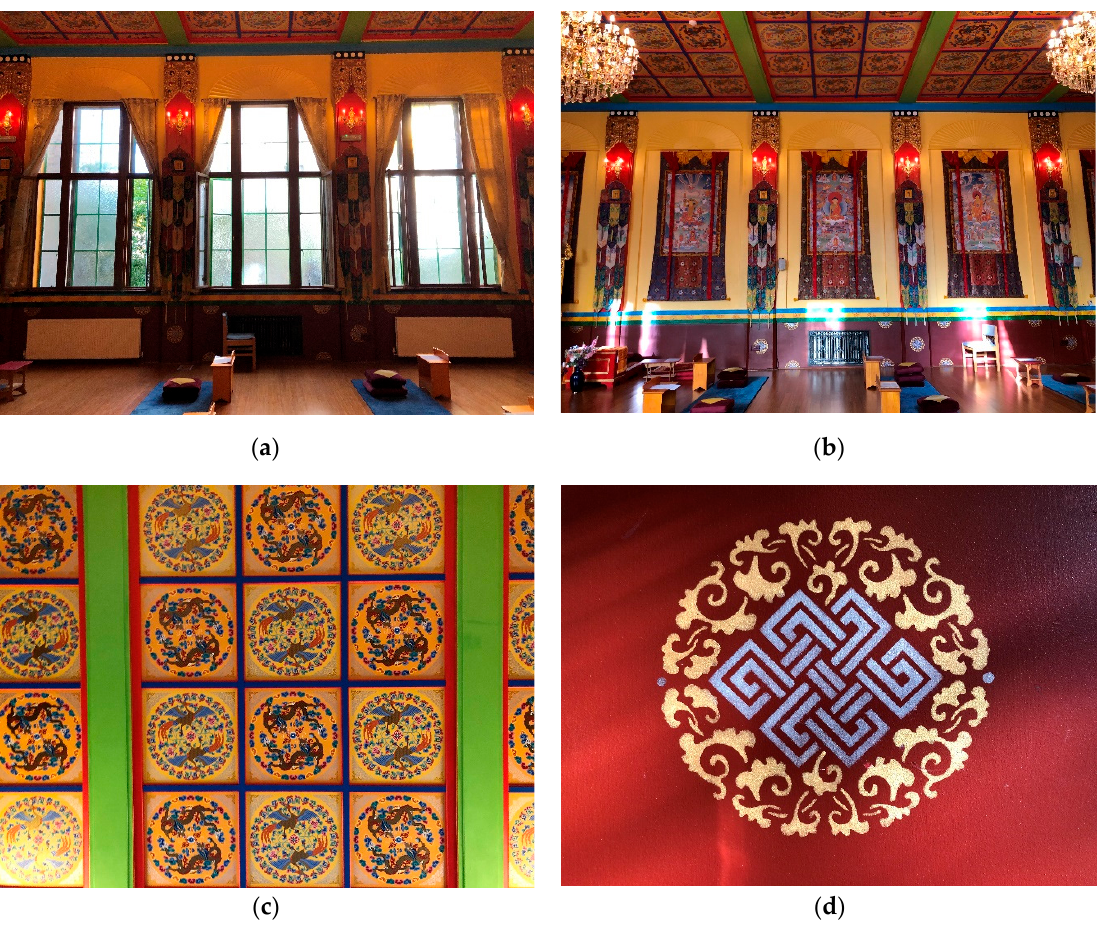
Figure 7. ( a ) Thangkas on the side of the wall; ( b ) window of the main shrine room; ( c ) ceiling of the main shrine room; ( d ) the Auspicious Knot pattern on the wall (photos by primary author).